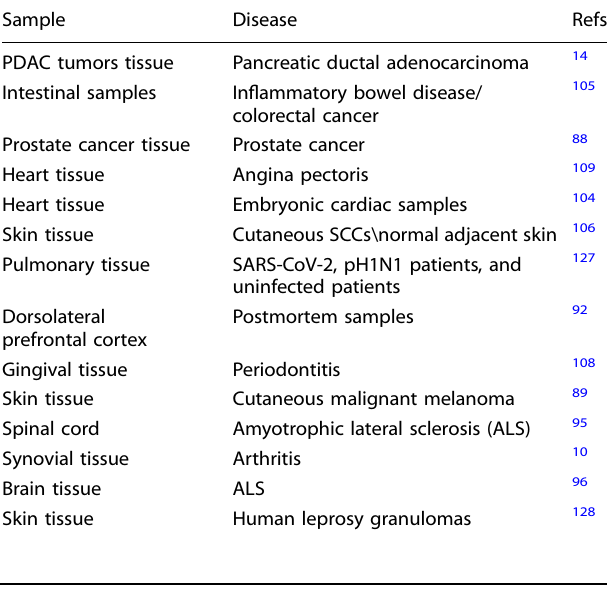
type fi broblast-like cells. By combining ST, scRNA-seq, and GO analysis it enabled a better identi fi cation for location distributions and gene markers of each cell type in the tissue (Fig. 5a), heart cell type-speci fi c genes, and interaction networks (Fig. 5b). Such mapping of the human embryonic heart allowed scientists to fully exploit valuable resources, cell-cell communication, and lineage development. By using 10× Genomics Visium and Space Ranger software, ST with scRNA-seq demonstrated the spatiotemporal atlas of human intestinal development and morphogenesis. 105 In this particular study, 77 intestinal samples were collected from 17 embryos representing different developmental time points and tissue locations, and 101 subgroups were identi fi ed in the compartment based on the fi ne cluster annotation of key marker genes. Transcriptional regulatory networks were positioned and exampled in Fig. 5c, to highlight the key regulatory network of each cell type and to reconstruct the “ decision tree ” of cell fate using scRNA-seq, including known developmental regulators, 306 developmental time courses, and 44 positional changes of regulatory networks. ST analysis of tissues from the entire intestinal development (Fig. 5c) revealed spatiotemporal locations of scRNA-seq-identi fi ed clusters, formation of epithelial crypt villi, differentiation of mesenchyme, establishment of muscle layer, expansion of vascular system, and immune colonization and appearance of gut-associated lymphoid tissue. 105 Each type of cells has speci fi c gene markers, of which some have location and outstanding fi ndings from this particular study provides new insights for understanding neonatal diseases and genetic defects of intestinal development (Table 5). ST in pathology ST-characterized 3D images present the heterogeneity of interac- tion between tumor and immune cells and the difference of in fi ltrated immune cells between locations. 106 Using machine learning models, capacities of analysis, description, and strati fi ca- tion of interaction between tumor and immunity were improved with high accuracy. 107 ST of melanoma lymph node biopsies revealed the heterogeneity of transcriptional landscape and gene expression pro fi les among spatial intra-tumoral compositions linked with histological entities 89 . The gene expression pattern